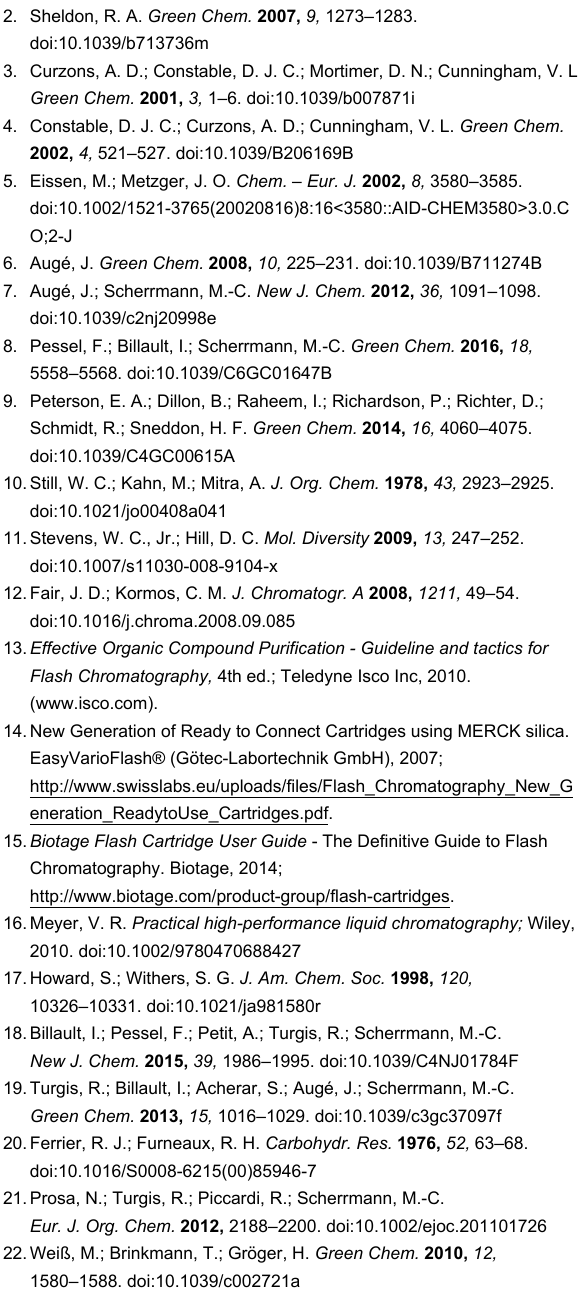
Figure 3: Comparison between calculated and experimental values of MI Chr for the reactions of Scheme 1.